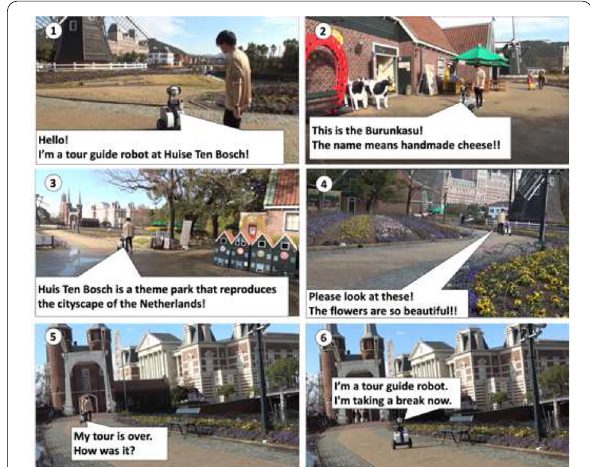
Fig. 28 Guided tour experiment using the 5G network